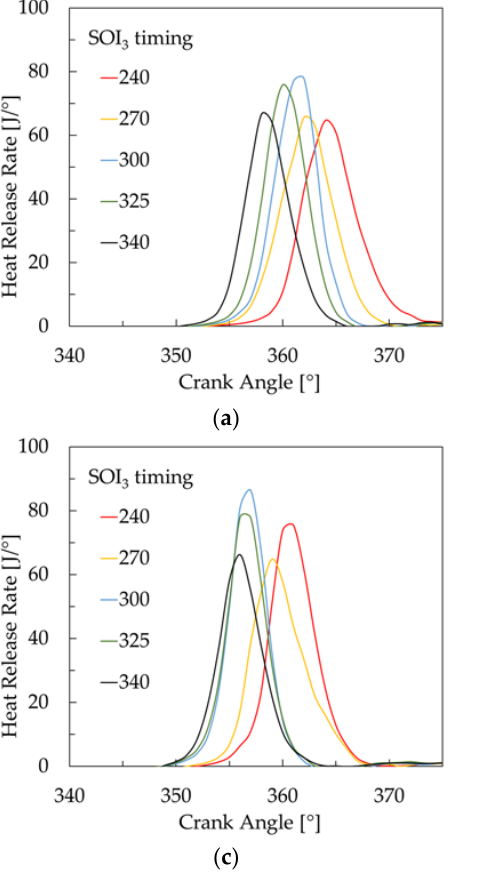
Figure 5. Calculated heat release rate: ( a ) λ = 1.3, m F3 = 2.4 mg; ( b ) λ = 1.3, m F3 = 5.2 mg; ( c ) λ = 1.6, m F3 = 2.4 mg; ( d ) λ = 1.6, m F3 = 5.2 mg.